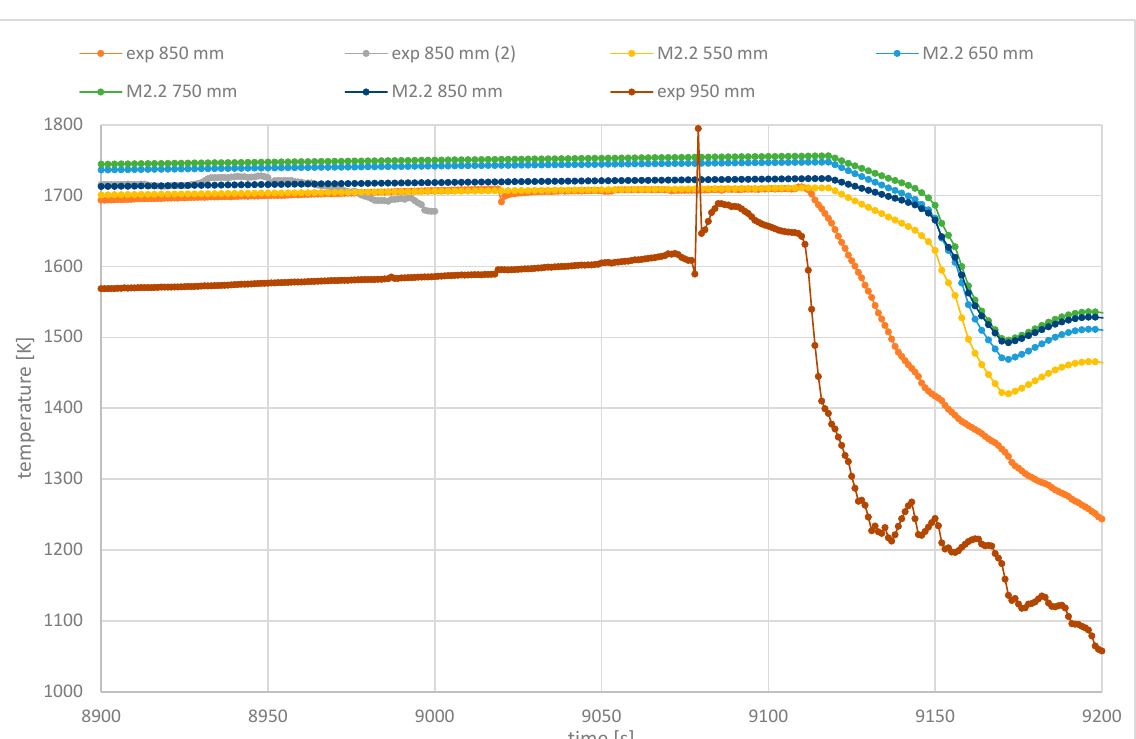
Figure 12. Comparison of the maximum temperatures of the test bundle heated rods (exp 850 mm, exp 850 mm (2)), and the central MELCOR calculation radial ring rods (M2.2 650 mm, M2.2 750 mm, M2.2 850 mm) [12].